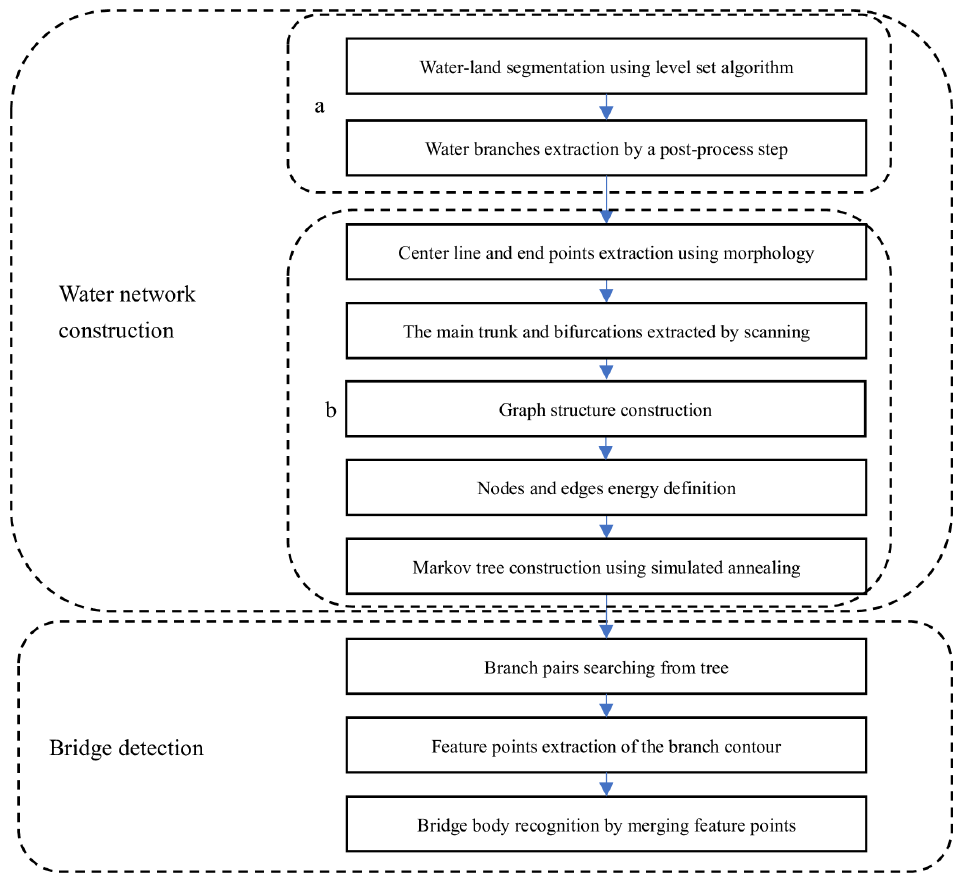
Figure 3. Diagram of the proposed bridge detection method based on water network construction using a Markov tree, where the steps of the water branch extraction are marked in box a, and the steps of the water branch connection are marked in box